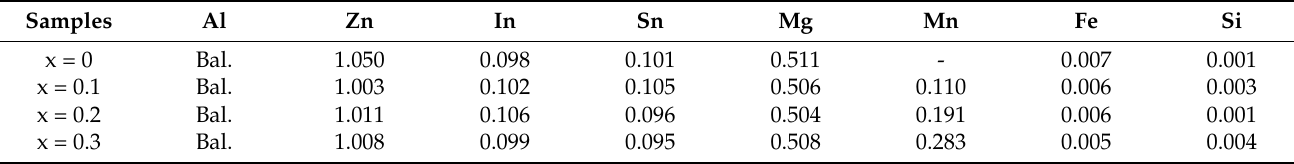
Table 1. The element compositions of the as-cast Al-1Zn-0.1In-0.1Sn-0.5Mg-xMn (x = 0, 0.1, 0.2, 0.3) (wt.%)